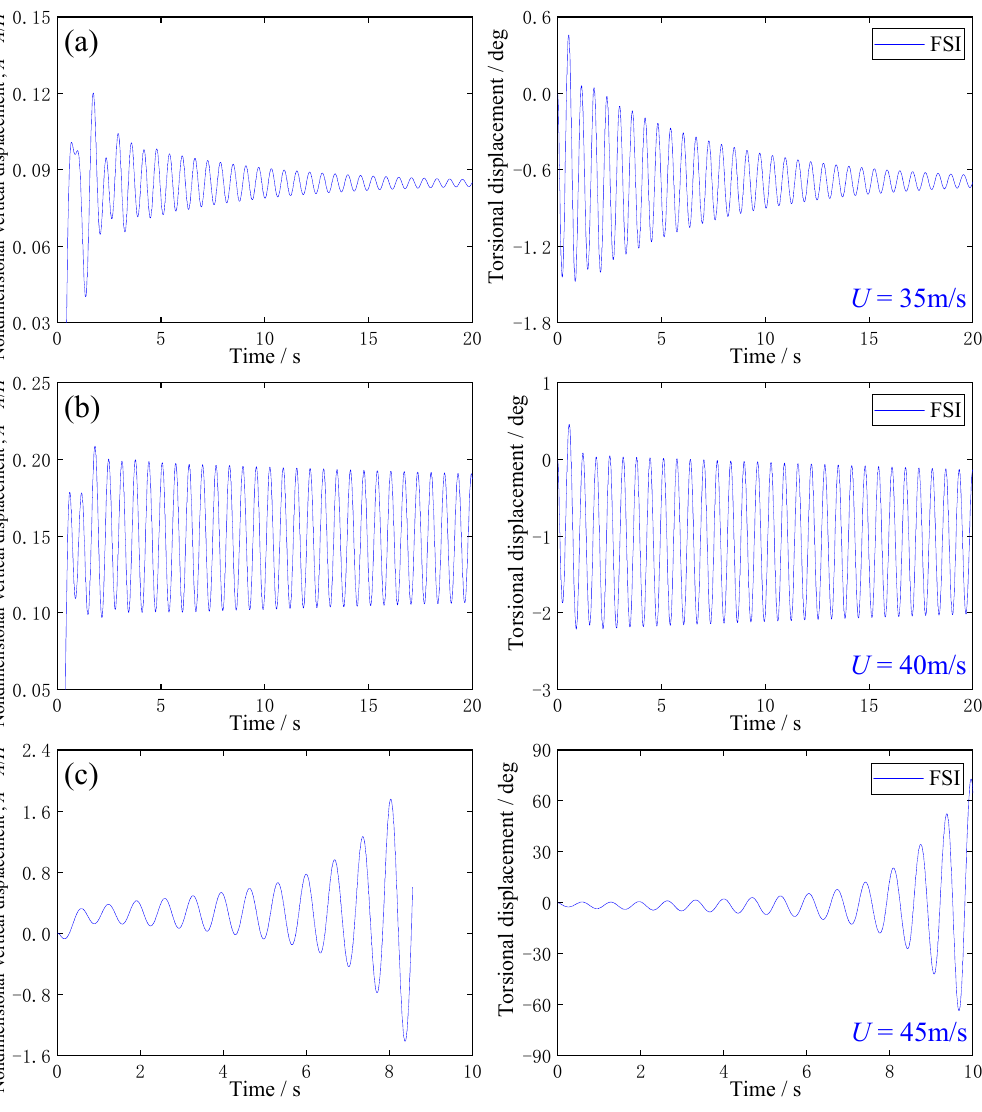
Figure 9. Vertical and torsional displacements of main deck section of GBEB, based on the FSI method for incoming wind speeds of ( a ) 35 m/s, ( b ) 40 m/s, and ( c ) 45 m/s for the prototype bridge, respectively. As shown in Figure 10, when the incoming wind speed is 35 m/s for the prototype main deck section, the torsional displacement and vertical displacement of the prototype girder have no obvious flutter divergence phenomenon. However, when the incoming wind speed is 40 m/s for the prototype main deck section, the torsional displacement and vertical displacement of the girder show a trend of slow divergence. Furthermore, when the incoming wind speed is 45 m/s for the prototype main deck section, the tor- sional displacement and vertical displacement of the girder have an obvious flutter di- vergence phenomenon. The calculation result of the flutter critical wind speed of the main girder section of GBEB obtained by the ROM method is about 40 m/s. Meanwhile, Figures 9 and 10 have consistency for the flutter analysis